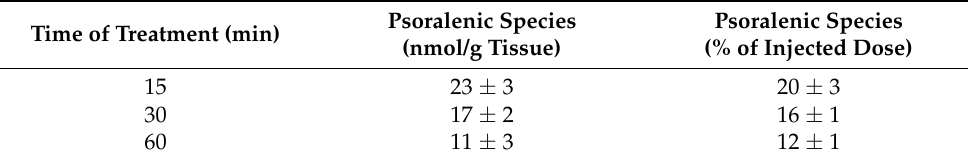
Table 3. Quantification of all the species with a psoralenic ultraviolet (UV) absorption spectrum extracted from the liver, and detected at 312 nm (assuming the same molar extinction coefficient for all species). No correction for recovery yield was applied. Data in the table are expressed as mean ± SEM ( n = 5, 4, and 6 for 15, 30 and 60 min, respectively). Psoralenic Species Psoralenic Species Time of Treatment (min) (nmol/g Tissue) (% of Injected Dose) 15 23 ± 3